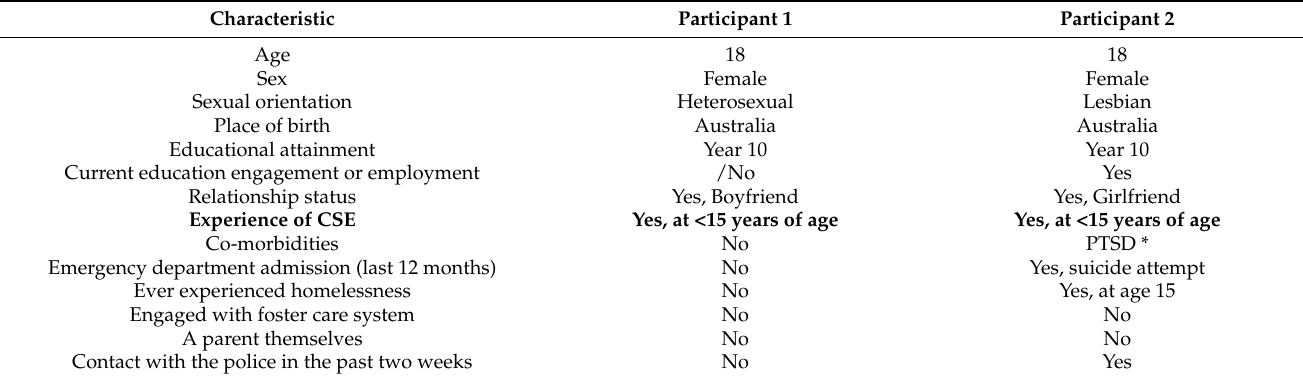
Table 1. Demographic characteristics of the